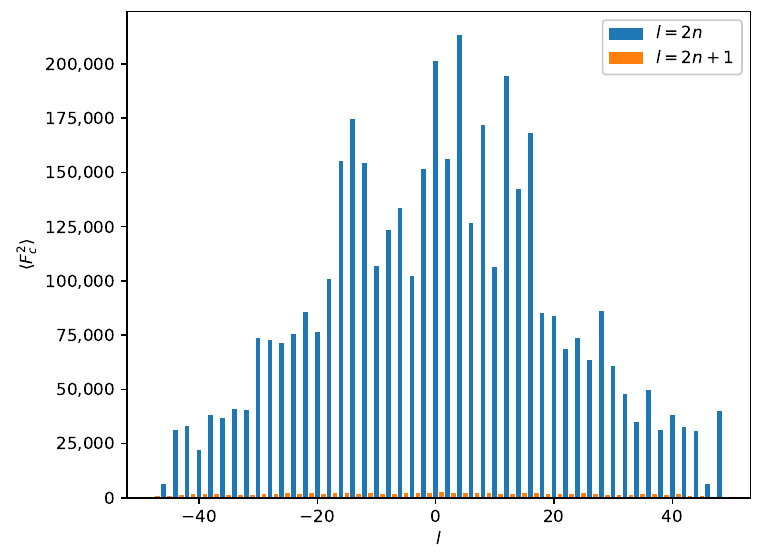
Figure 4. Average F 2 c for a perfect twin in the P 2 1 supercell for reflections with h = 2 n . The l-index is shown on the x -axis. Reflections with l = 2 n + 1 are absent (small orange bars). Systematic absences